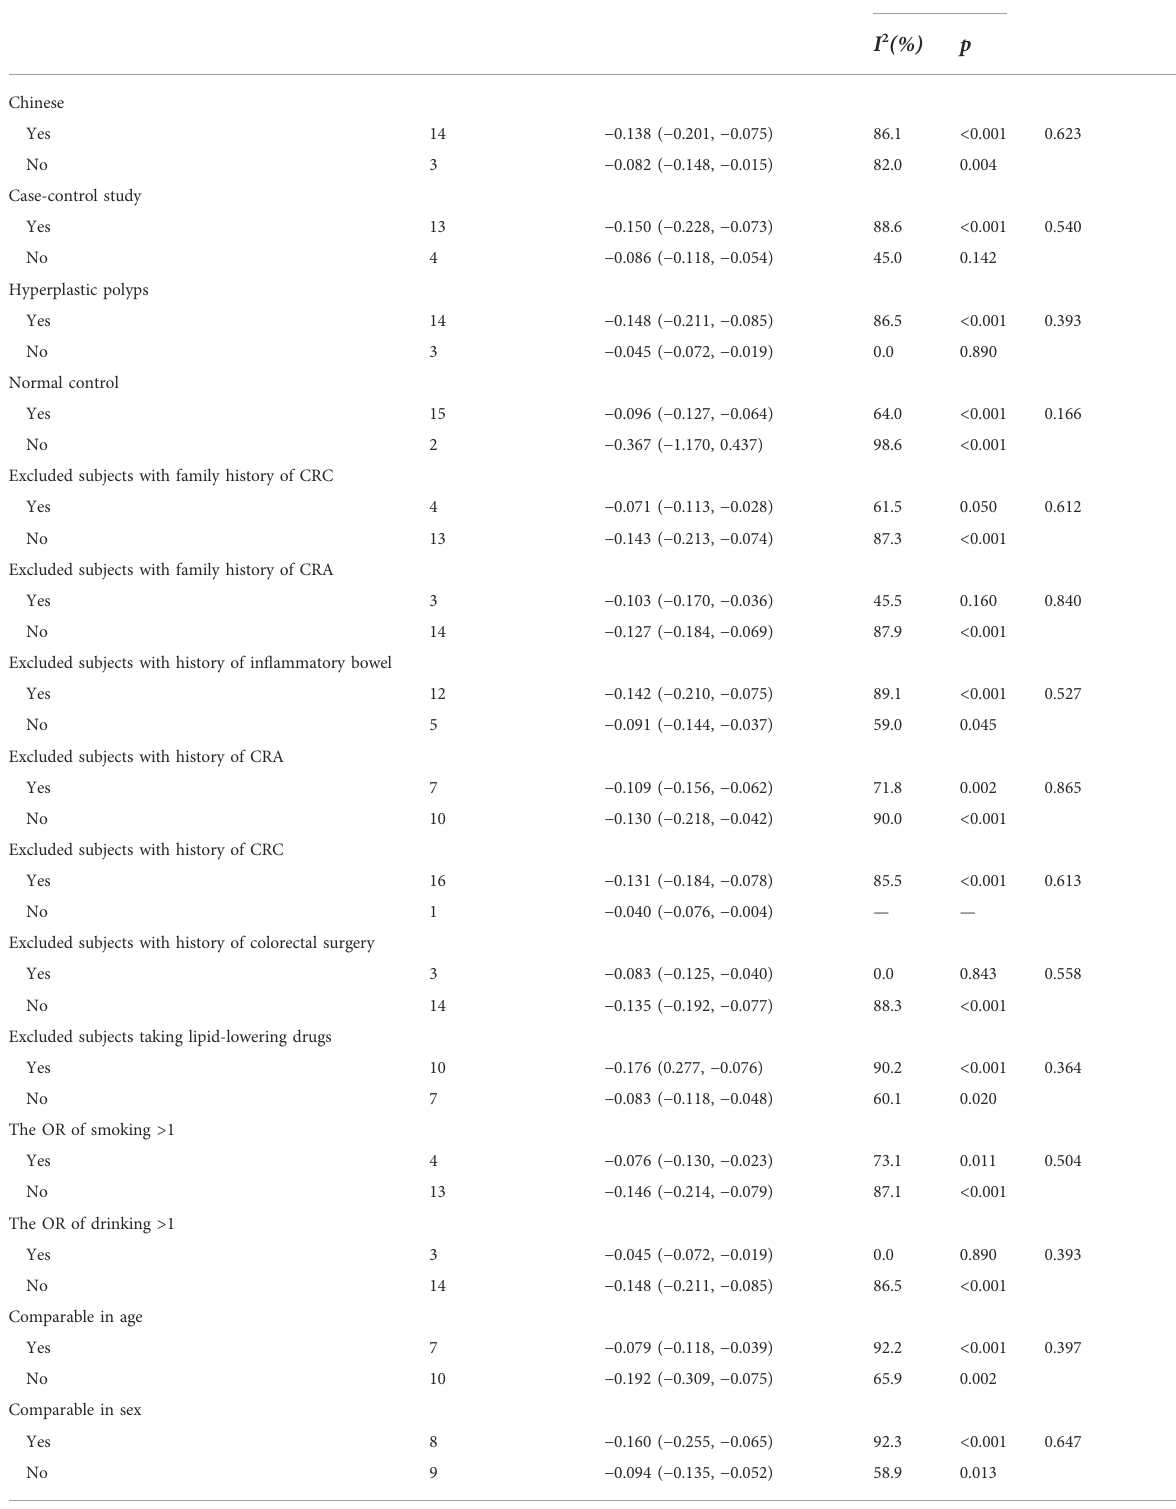
TABLE 2 Heterogeneity source analyses for mean difference of